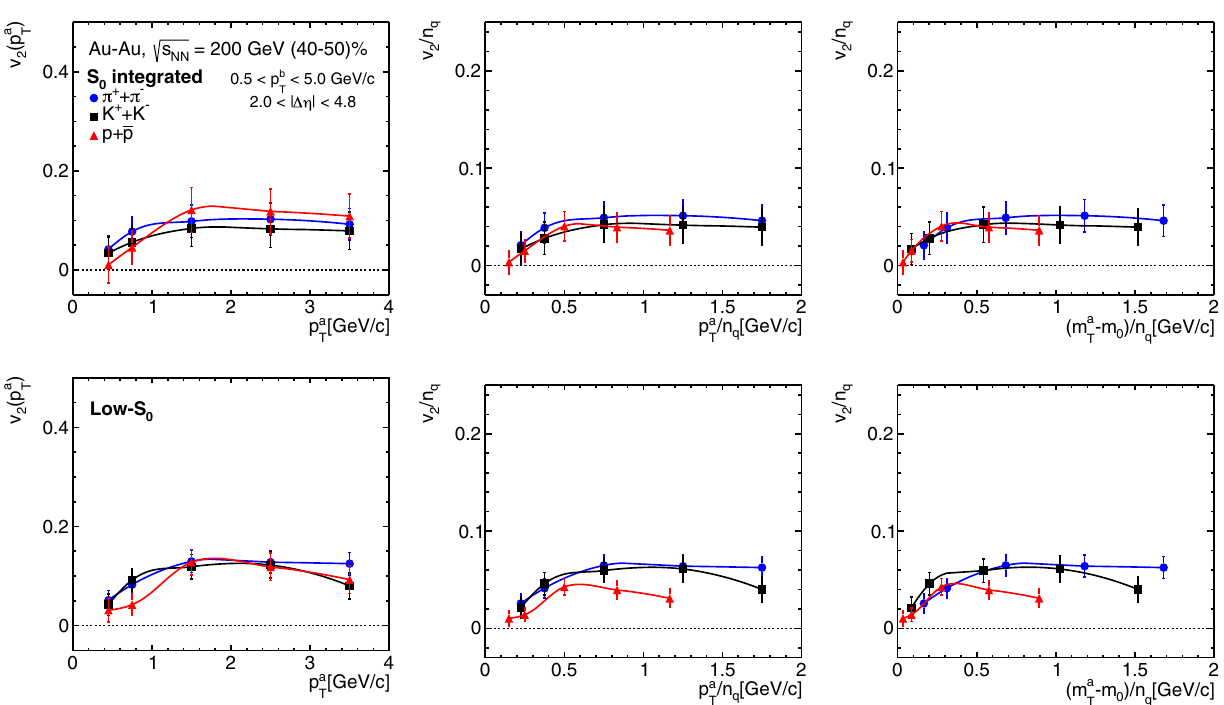
Fig. 9 Elliptic flow co-efficient (left) with number of quark participant scaling ( v 2 ( p a )/ n q ) (middle) and with transverse mass ( m T ) scaling T (right) as a function of p a of pions (blue circles), kaons (black squares) T